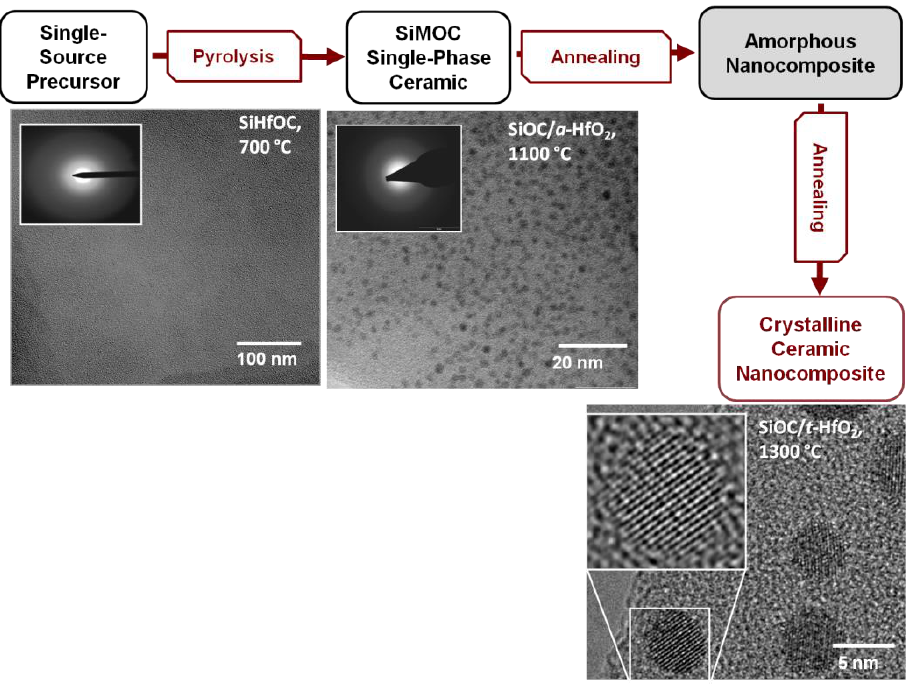
Figure 7. Single-source-precursor synthesis of polymer-derived ceramic nanocomposites (PDC-NCs). Pyrolysis of suitable alkoxysilanes, Si(OR) 4 , or polysiloxanes, –[Si(R) 2 –O] n , chemically modified with metal alkoxides was shown to give MO x /SiOC-based PDC-NCs, as reported for M = Al [179,211], Ti [54,58], Zr [203,212], Hf [201,213], etc . For M = Zr and Hf a single-phase SiMOC ceramic is obtained upon pyrolysis at rather low temperatures ( ca. 700 °C), while at higher temperatures amorphous MO 2 nanoparticles precipitate (800–1100 °C). Upon increasing the annealing temperature to 1300 °C, MO 2 nanoparticles crystallize, forming microstructures comprised of tetragonal zirconia/hafnia particles finely dispersed within an amorphous SiOC matrix